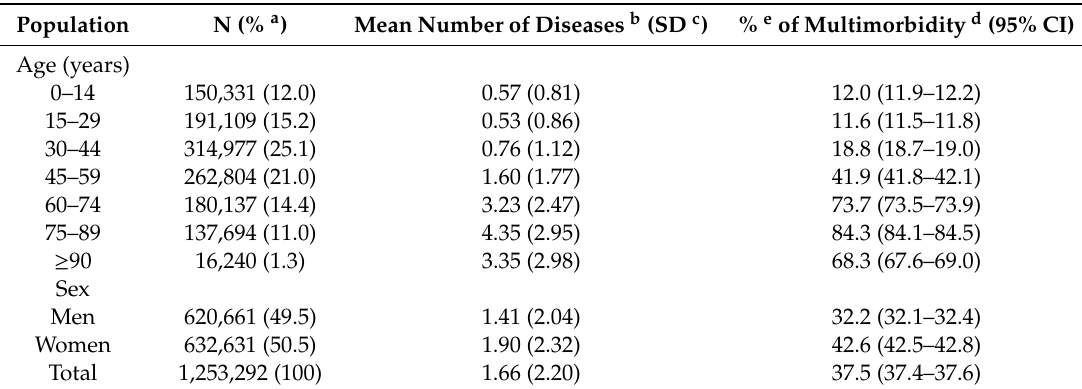
Table 1. Characteristics of the study